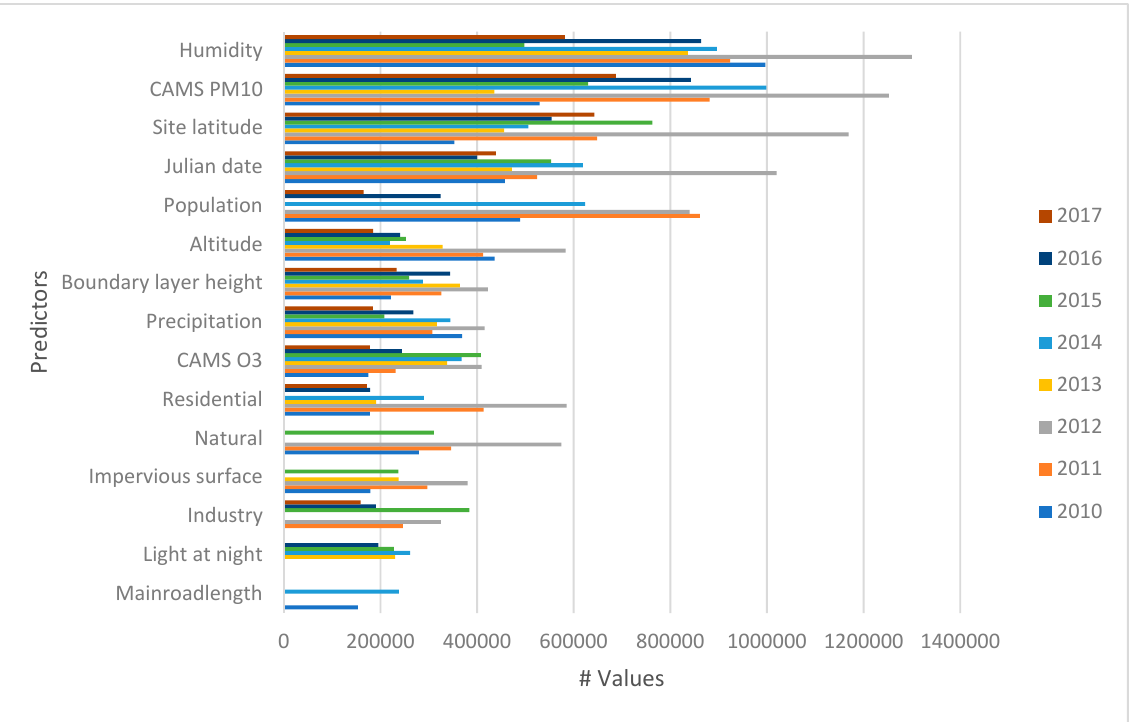
Figure 3. National model variable of importance.